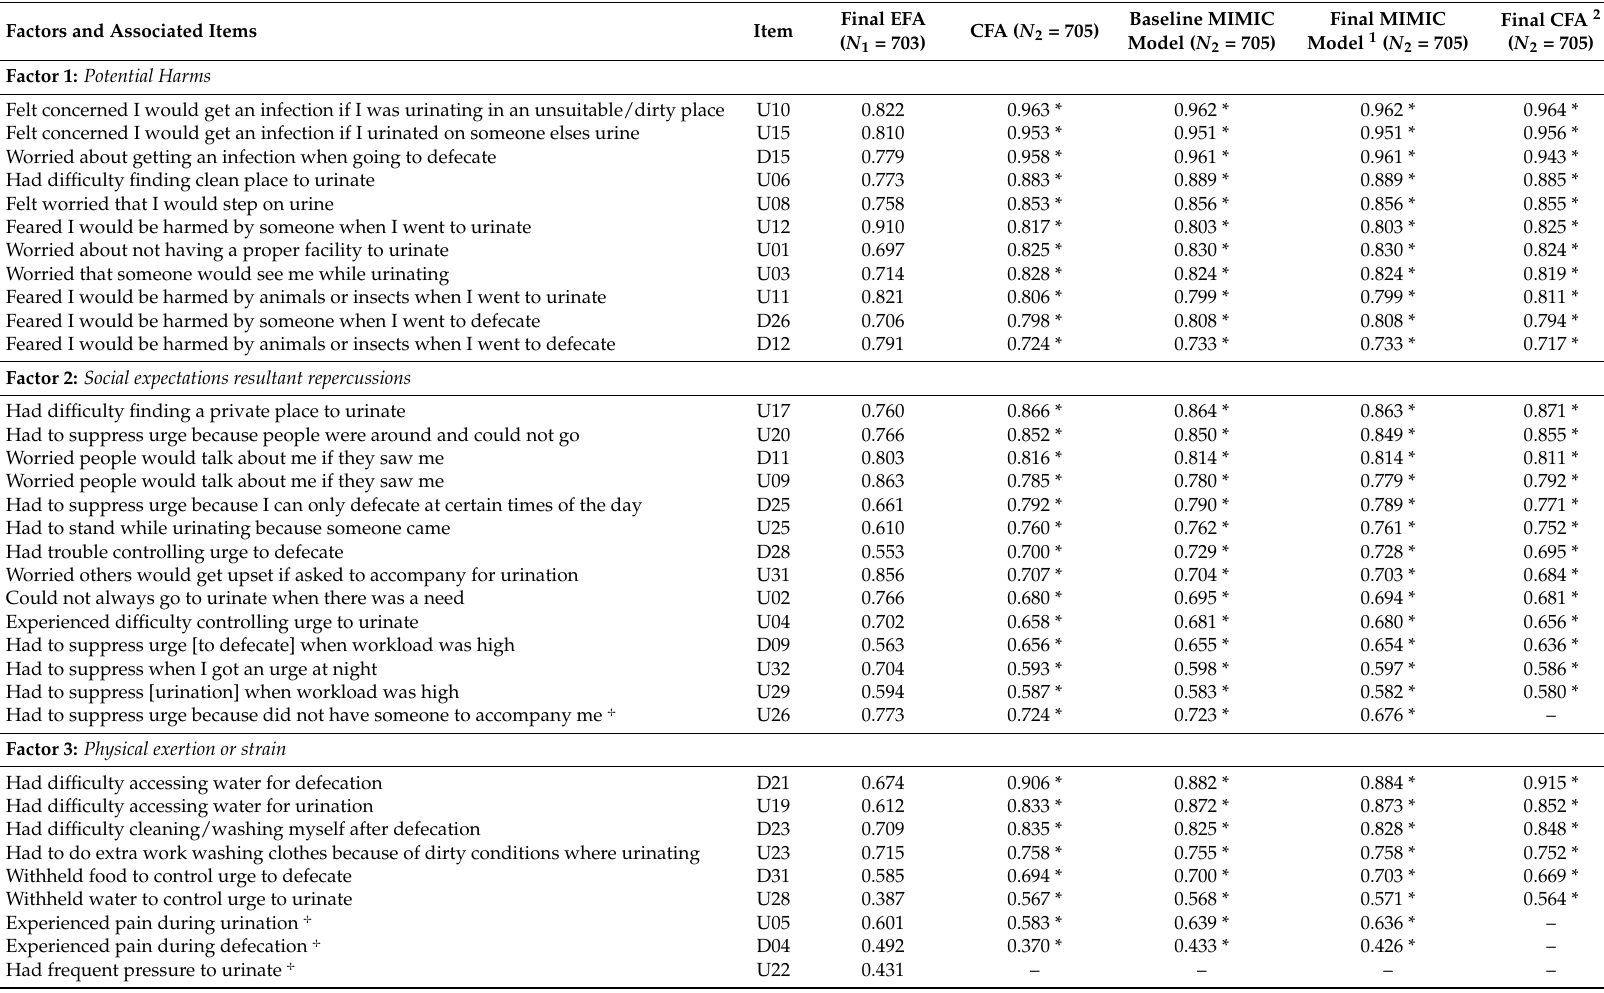
Table 2. Factor loadings for random split–half sample EFA ( N 1 = 703) and CFA models ( N 2 = 705), baseline and final MIMIC models ( N 2 = 708), and final CFA model ( N 2 = 708) with deletions based on